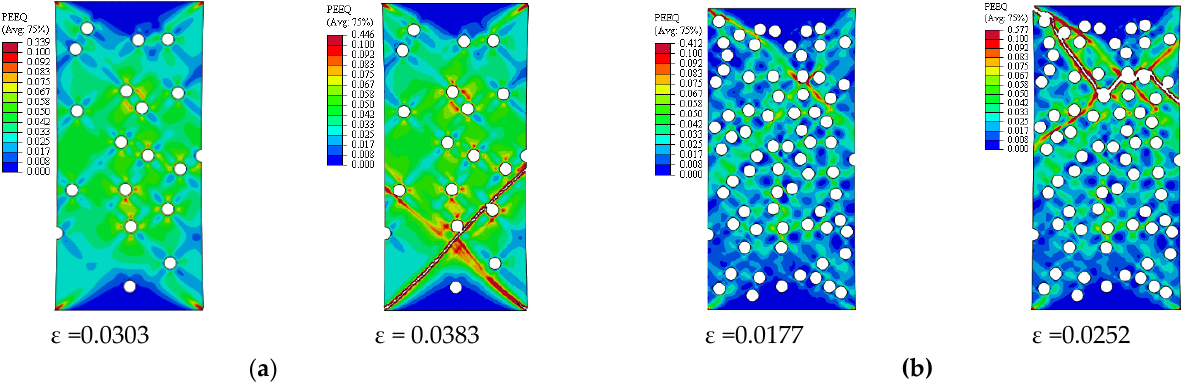
Figure 11. Effective plastic strain in the matrix of A359/SiC composite (PS = 10 µm): ( a ) 5% VF; ( b ) 20% VF.